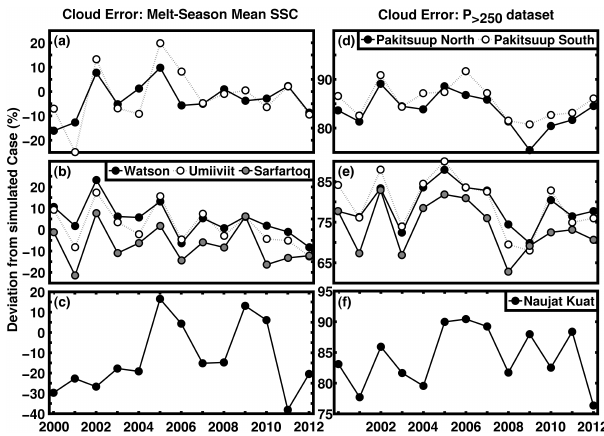
Figure 7. Percent deviation of annual plume metrics from simu- lated data set was used to constrain error budget. P > 50 values (not plotted) are similar to P > 250